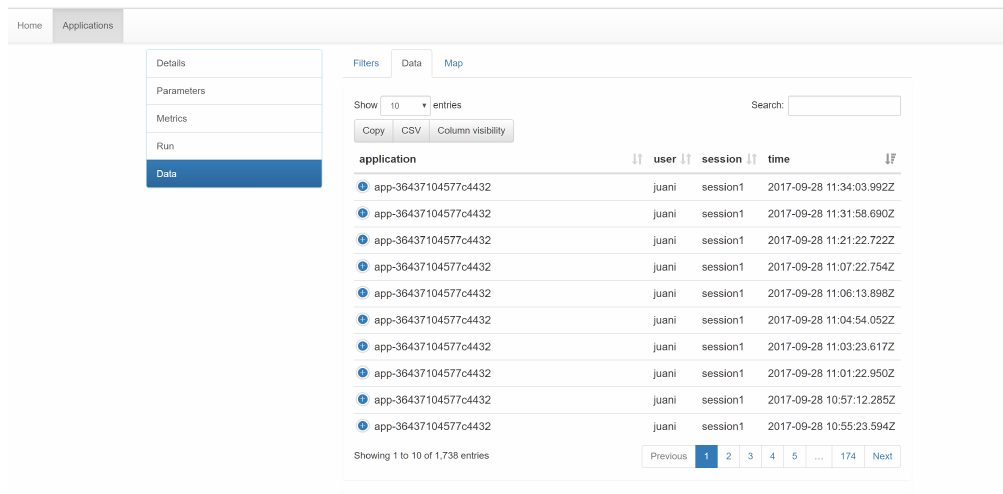
Figure 11. Tabular-based visualisation of the data in Figure